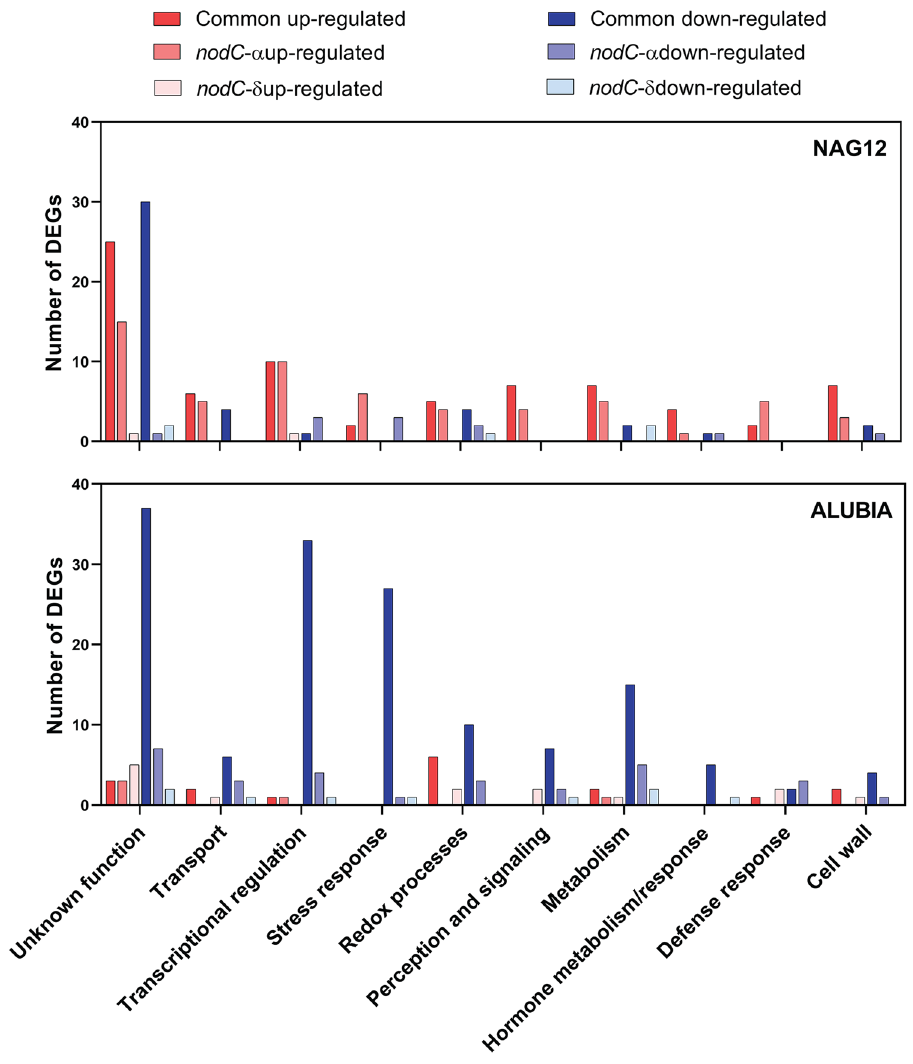
Figure 4. Functional categories of DEGs modulated by nod C-α or nod C-δ R. etli strains in each P. vulgaris accession. DEGs that respond to all strains, nod C-α (SC15 and CE3) or nod C-δ R. etli (55N1 and 124N1) strains in NAG12 (upper panel) and Alubia (bottom panel) were manually classified into functional categories using GO terms. Bars represent the number of DEGs up- and down-regulated in each category. The top 10 functional categories are